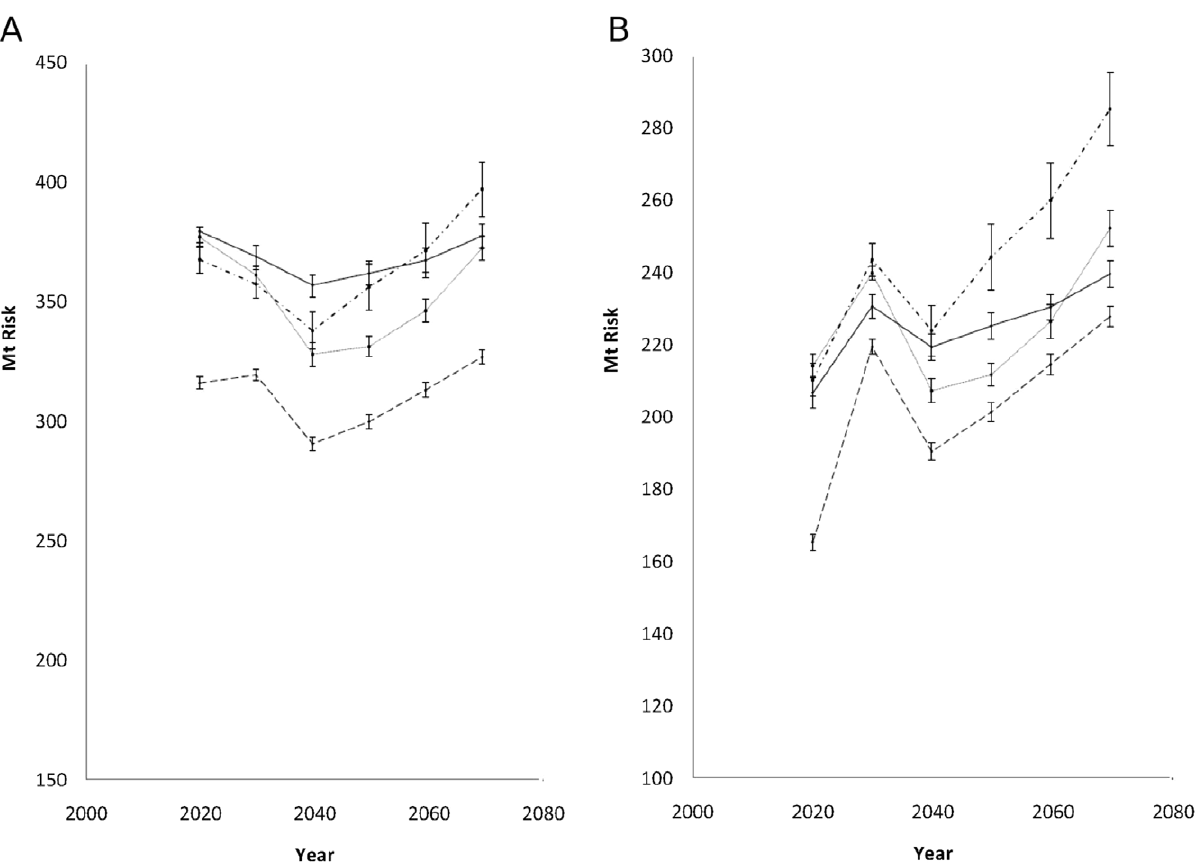
Figure 6. Future trends in fasciolosis risk. Predicted change in F. hepatica risk for England (dashed line), Scotland (solid line), Wales (dashed and dotted line) and Northern Ireland (dotted line), 2020–2070 ( 6 SE) for a) summer and b)